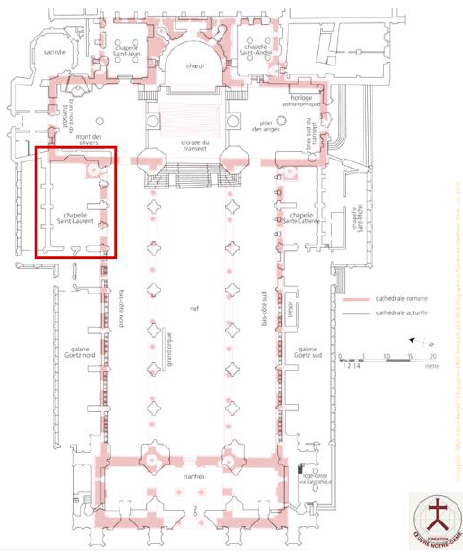
Figure 1. Location of the St. Lawrence’s Chapel (red frame) in the Strasbourg’s